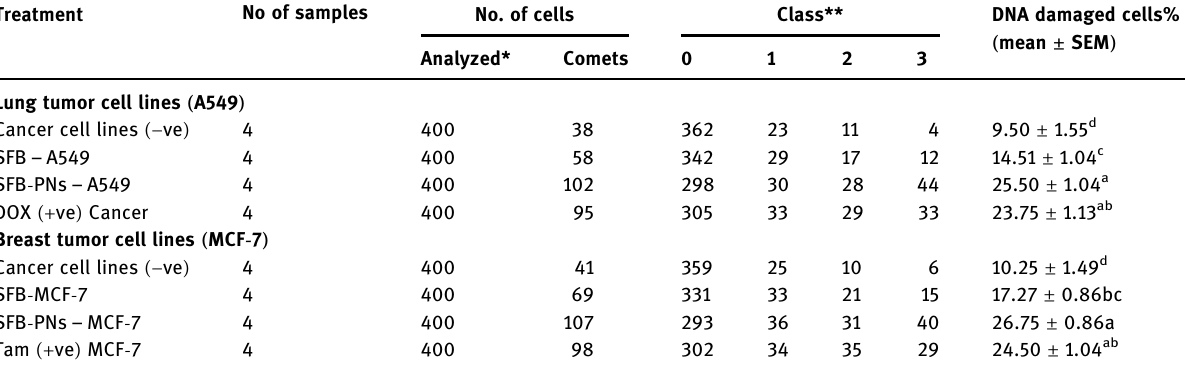
Table 2: Visual score of DNA damage in lung and breast tumor cell lines treated with SFB, SFB - NPs, DOX, and Tam